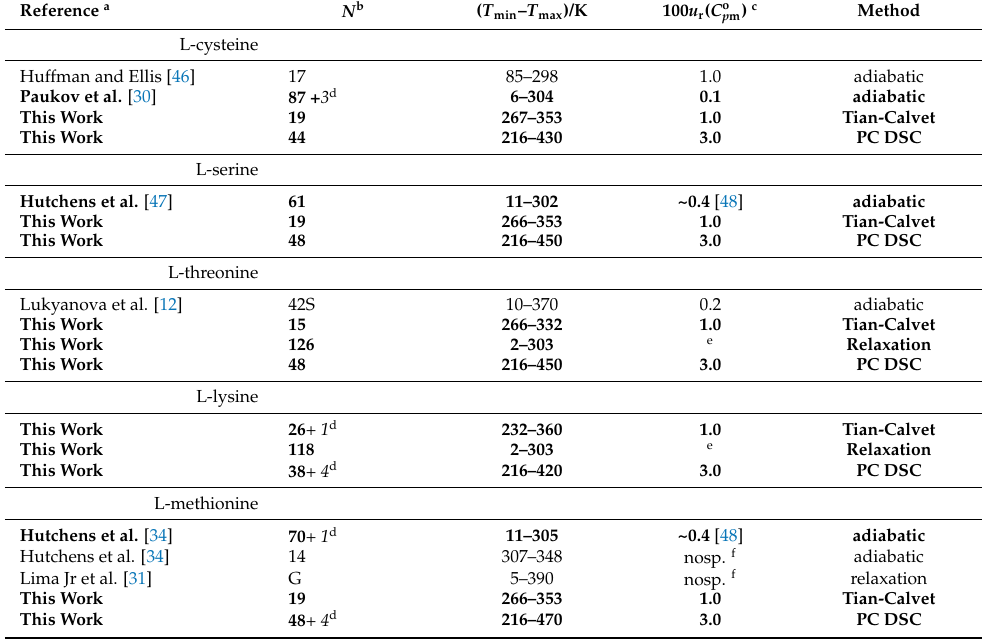
Table 4. Overview of the Literature Crystal Heat Capacities of L-Cysteine, L-Serine, L-Threonine, L-Lysine, and